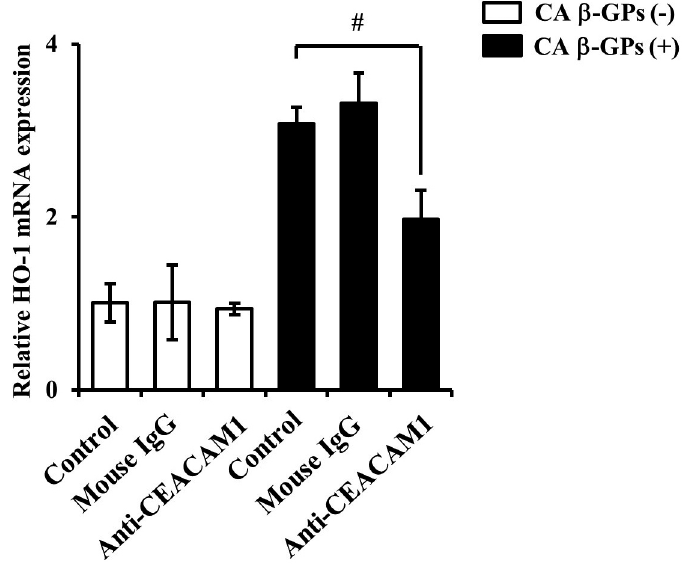
Figure 7- Effects of CEACAM1 neutralizing antibody on β-GPs-induced HO-1 mRNA expression in RT7 cells Cells were pre-incubated with the neutralizing antibody for CEACAM1 and mouse IgG as the negative control (each 10 μg/mL) for 1 hour, then exposed to C. albicans β-glucan-containing particles (CA β-GPs) (200 μg/mL) for 12 hours. HO-1 mRNA levels are shown as relative to that of β-actin. Values are shown as fold increase as compared to the control cells and presented as the mean ± SD of three independent experiments. #Significant decrease as compared with C. albicans β-GPs alone (Bonferroni/Dunn's multiple comparison test: